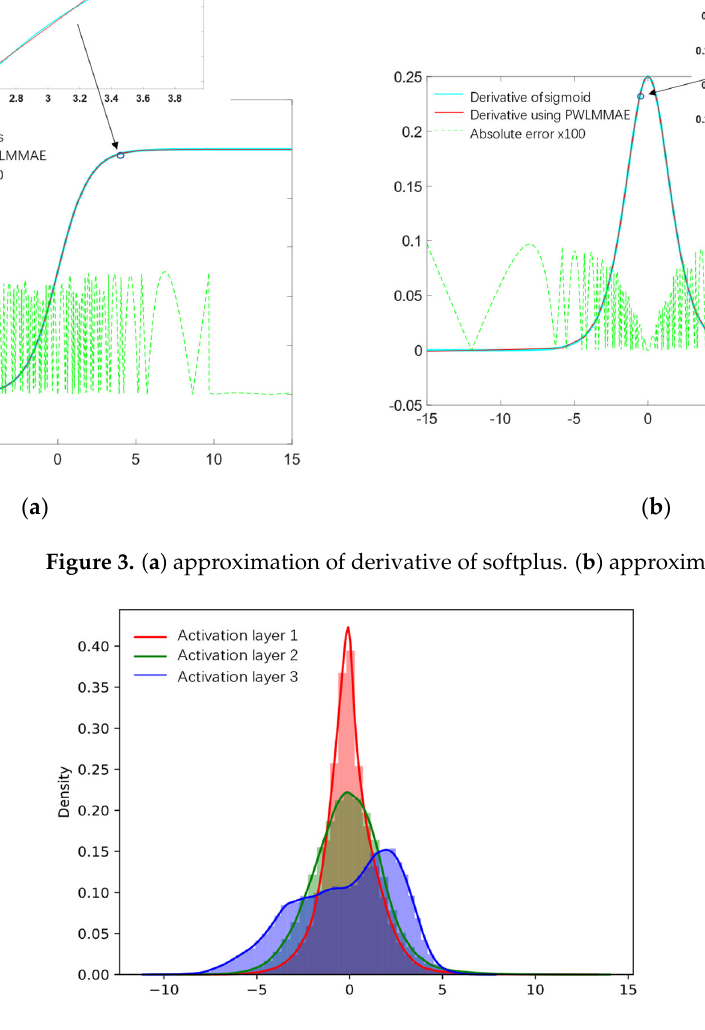
Figure 4. Distribution of inputs for each activation layer.